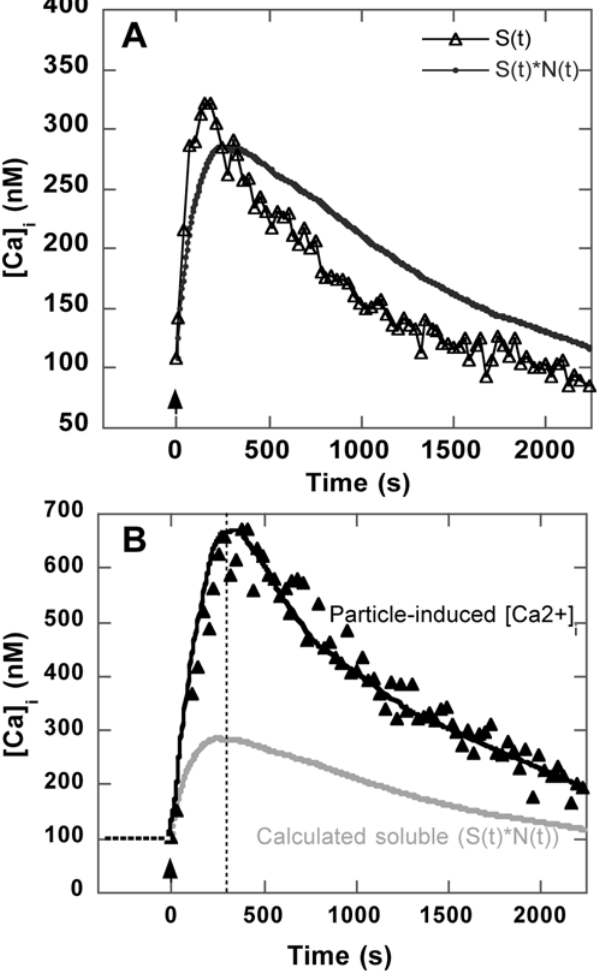
Figure 6. Comparison of colloidal versus soluble anti-CD3- induced calcium signal. (A) S(t) ( D ), the calcium signal induced by 0.5 m g/ml soluble anti-CD3, is displayed with C(t) ( N ), the convolution of S(t) with the time function reporting growth of the particle-bearing cell population, N(t)= N max (1 2 exp( 2 kt) using k =0.11 min 2 1 . (B) The convoluted signal C(t) ( N ) is shown with calcium signal induced by particles. Maximum signal is obtained near 300 s (indicated by dashed